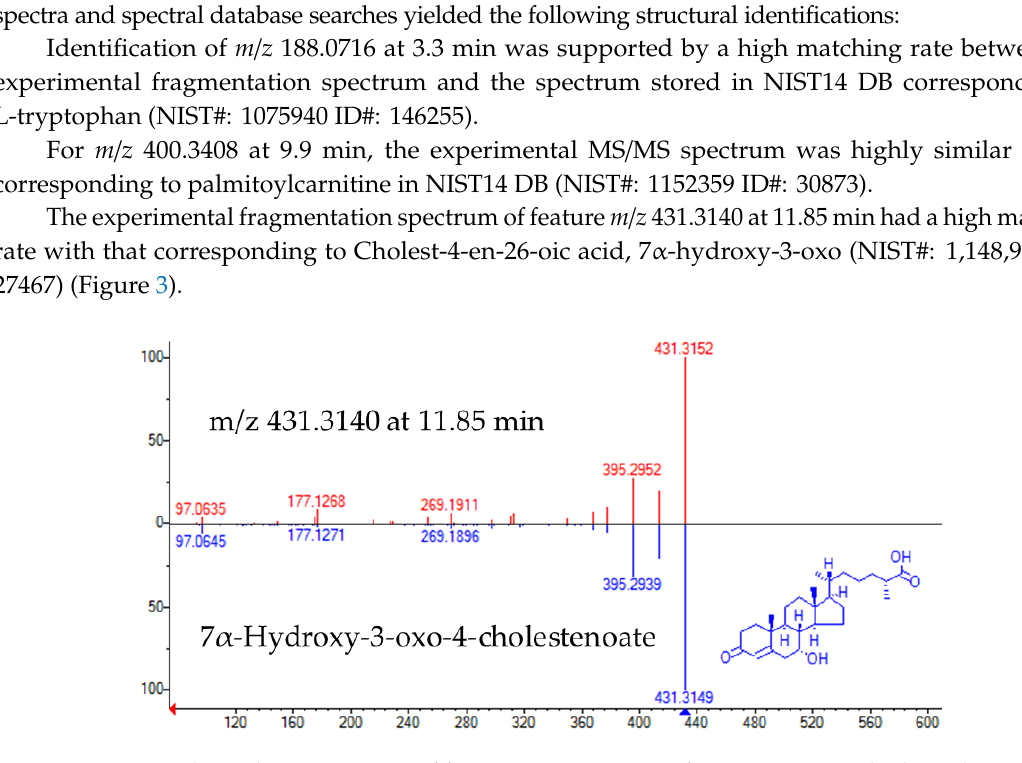
Figure 3. Head to tail representation of fragmentation spectra of m / z 431.3140 in a biological